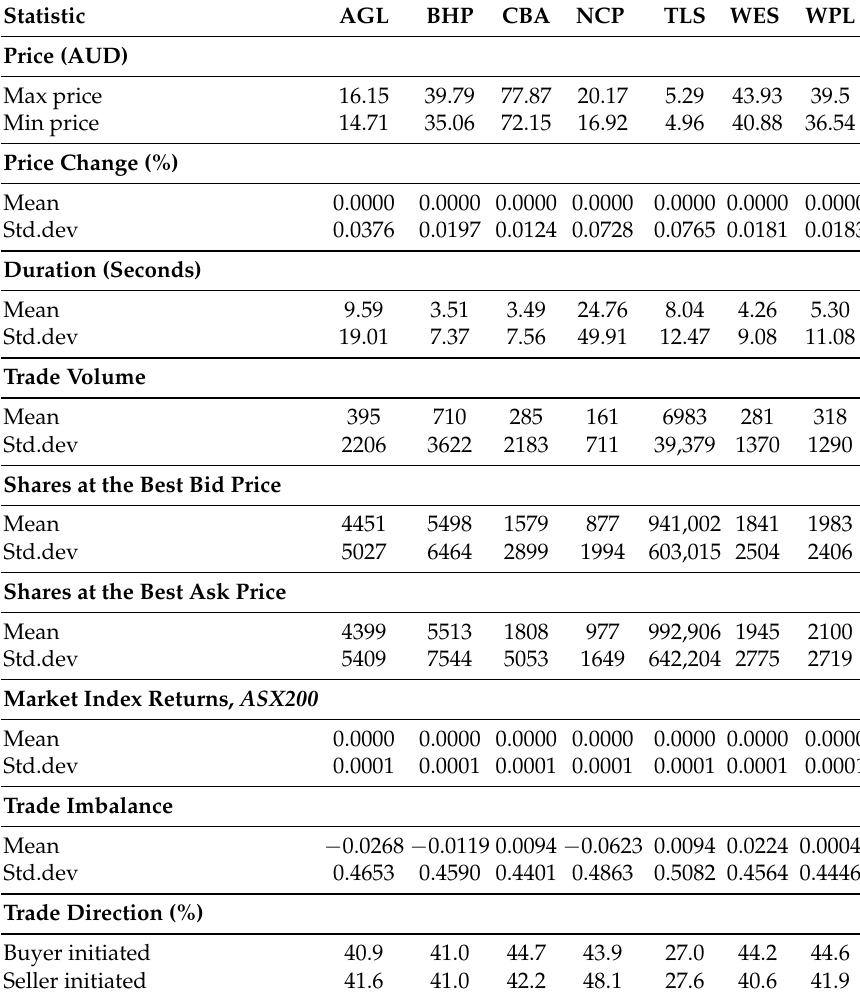
Table 1. Descriptive statistics of the variables considered in the ordered probit model for all the stocks, for the period from 16 January 2014 to 15 April